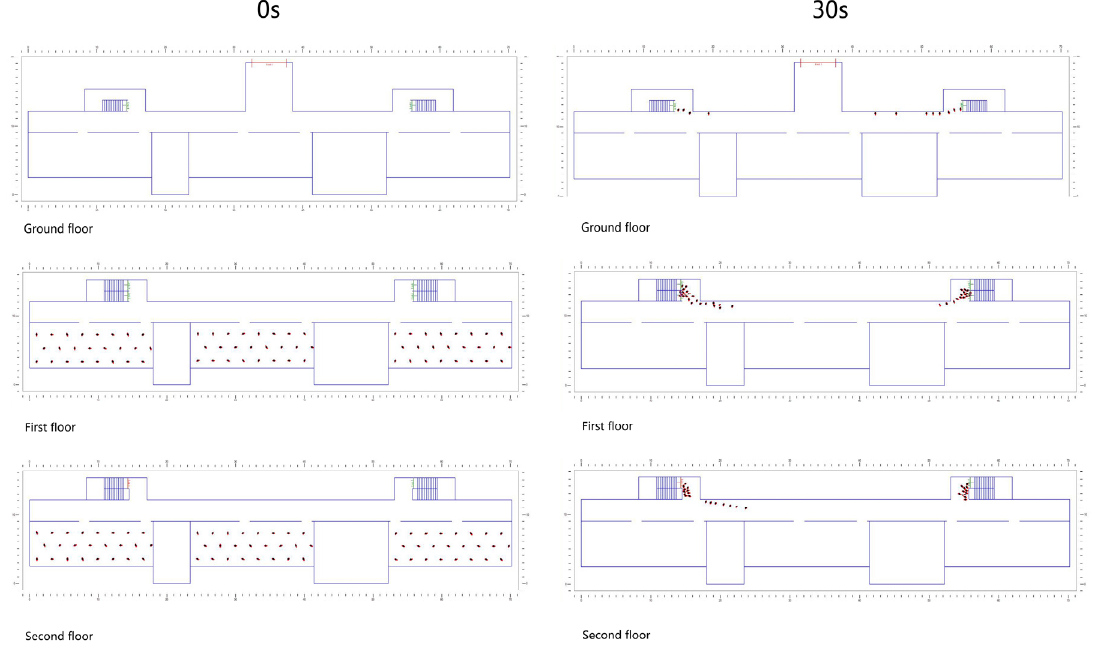
Figure 6. Snapshot of the evacuation simulation.